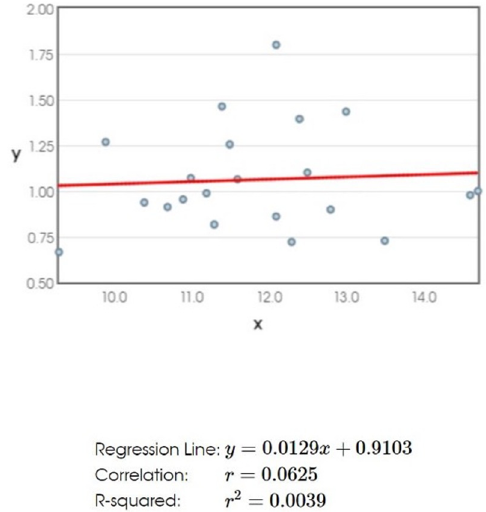
Figure 4. Correlation between initial soft tissue thickness in the maxilla (x axis) and the relation between postoperative soft and hard tissue movement (y axis)—cases of maxillary advancement of 5 mm or less (N = 16, p = 0.28). Correlation between initial soft tissue thickness in the mandible (x axis) and the relation between postoperative soft and hard tissue movement (y axis)—mandibular setback cases (N = 21, p = 0.79).